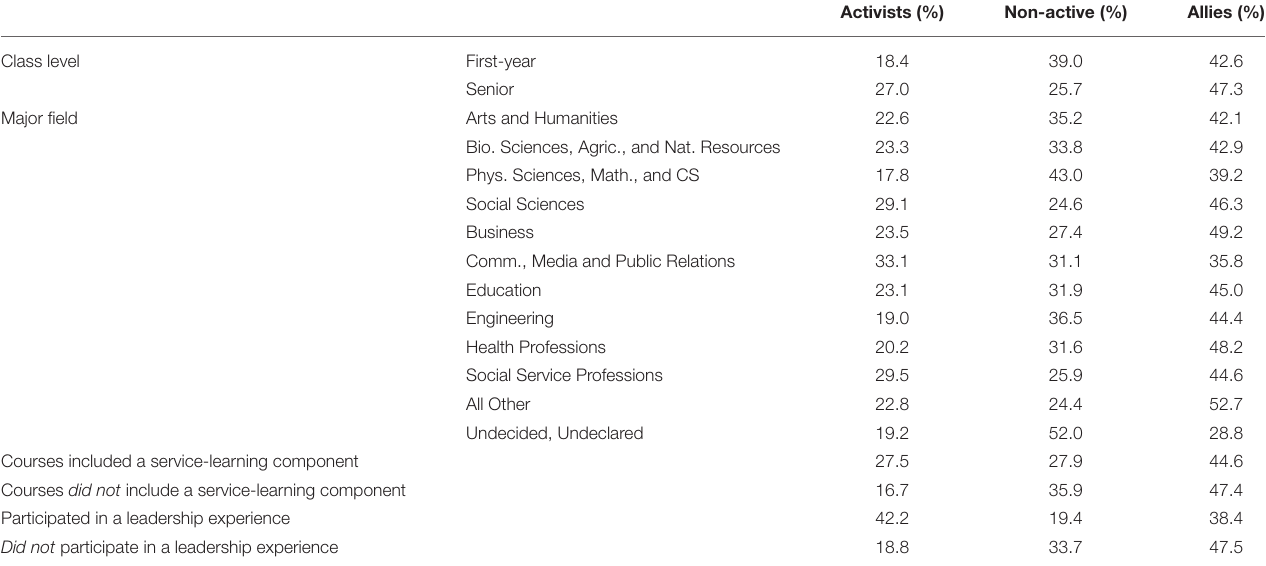
TABLE 5 | Select student characteristics and experiential activities by civic engagement student